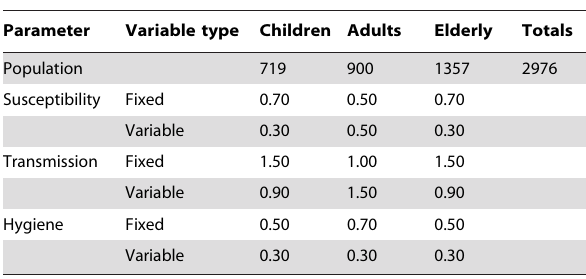
Table 1. The parameters used for the extended families.